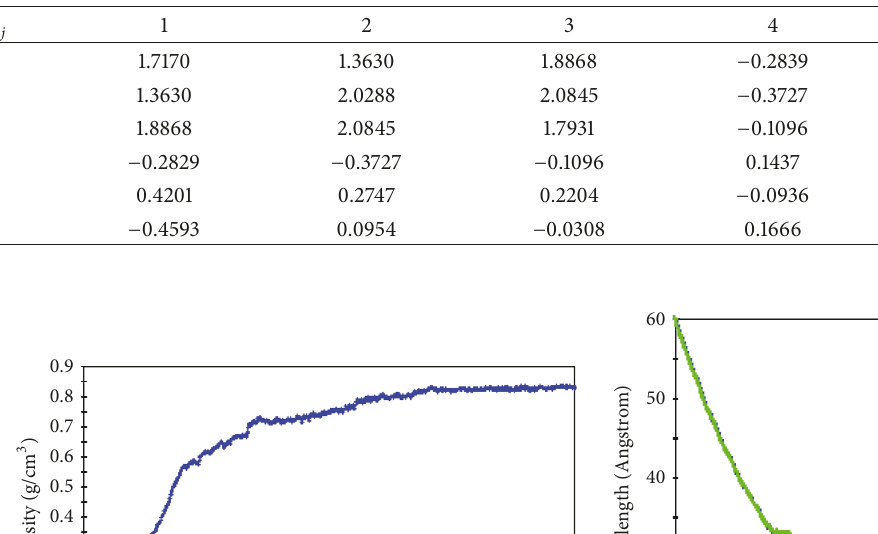
Table 2: Stiffness matrix obtained for saturated phenol model.